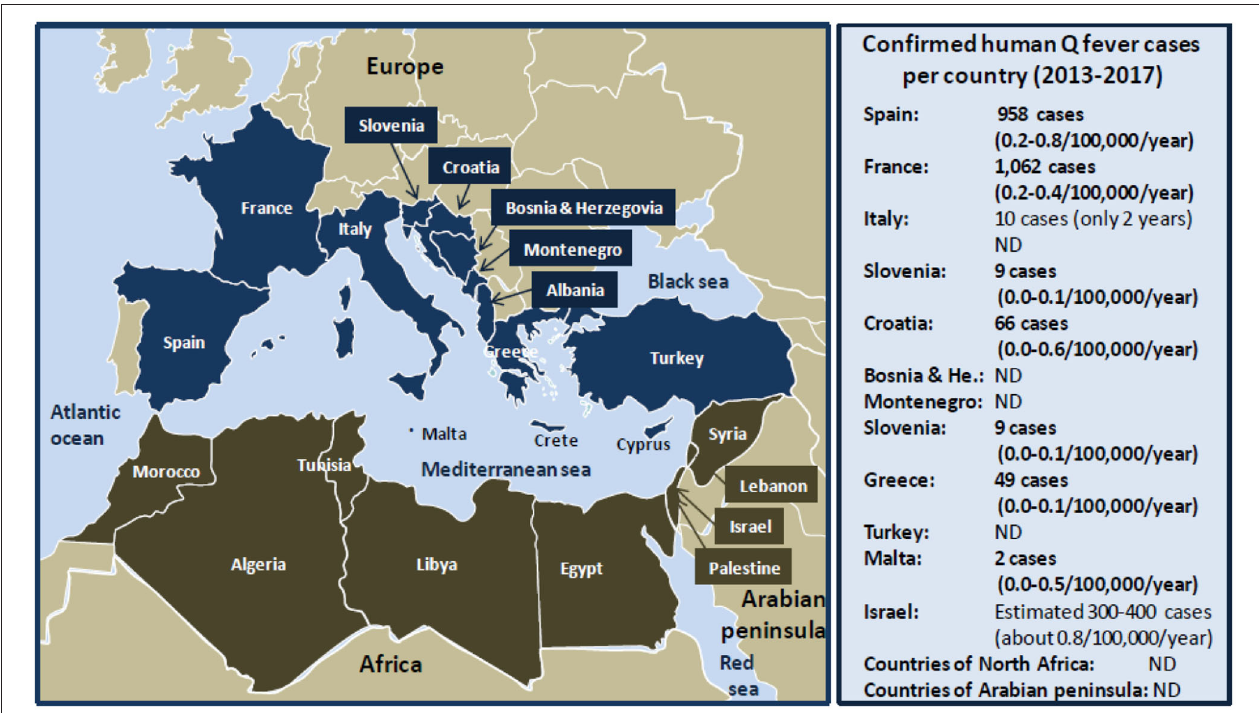
FIGURE 2 | Schematic representation of human Q fever around the Mediterranean. Left panel: map of the Mediterranean basin. The Mediterranean Sea is bordered by 22 riparian countries. The countries of the Northern Mediterranean coast are represented in dark blue, and the countries of the Southern Mediterranean coast are represented in tanned brown. Right panel: confirmed human Q fever cases per country during the period 2013 to 2017 according to the ECDC (21). Q fever surveillance report, 2017. Values between brackets indicate the average number of Q fever cases per 100,000 inhabitants per year over the 5 years period. Regarding Italy, no data were available for the years 2013, 2014, and 2015. The number of cases of Q fever for Israel over the period 2013 to 2017 was extrapolated from the data published by Yarrow and colleagues ( 111). ND, not determined. Human Q fever occurs mostly in the form of sporadic cases. Sometimes outbreaks of Q fever were reported in humans. The main epidemics of Q fever described during the last 40 years in people living on the Northern coast of the Mediterranean basin are as follows: 2003 (60 cases), 2004 (16 cases), 2014 (50 cases) in Spain; 1992 (40 cases), 1996 (204 cases), 2002 (126 cases), 2009 (50 cases), 2014 (46 cases) in France; 1993 (58 cases), 2003 (133 cases) in Italy; 2007 (33 cases) in Slovenia; 2004 (14 cases) in Croatia; 2007 (42 cases) in Albania; 2009 (58 cases) in Greece; and 2002 (19 cases) in Turkey. Human Q fever outbreaks are poorly documented concerning the countries of the Southern Mediterranean Sea coast. An epidemics of Q fever was described in 1955 in Algeria with 175